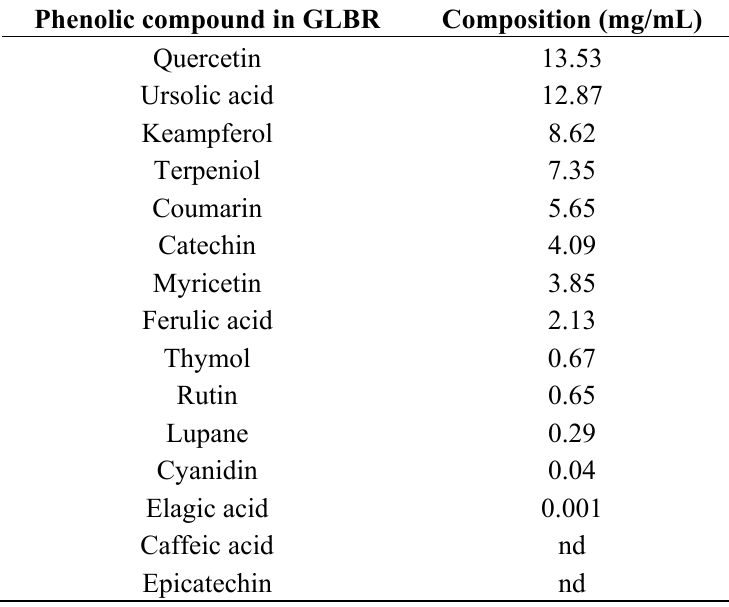
Table 1. Phenolic composition of Ganoderma lucidum grown on germinated brown rice (GLBR) extract by HPLC